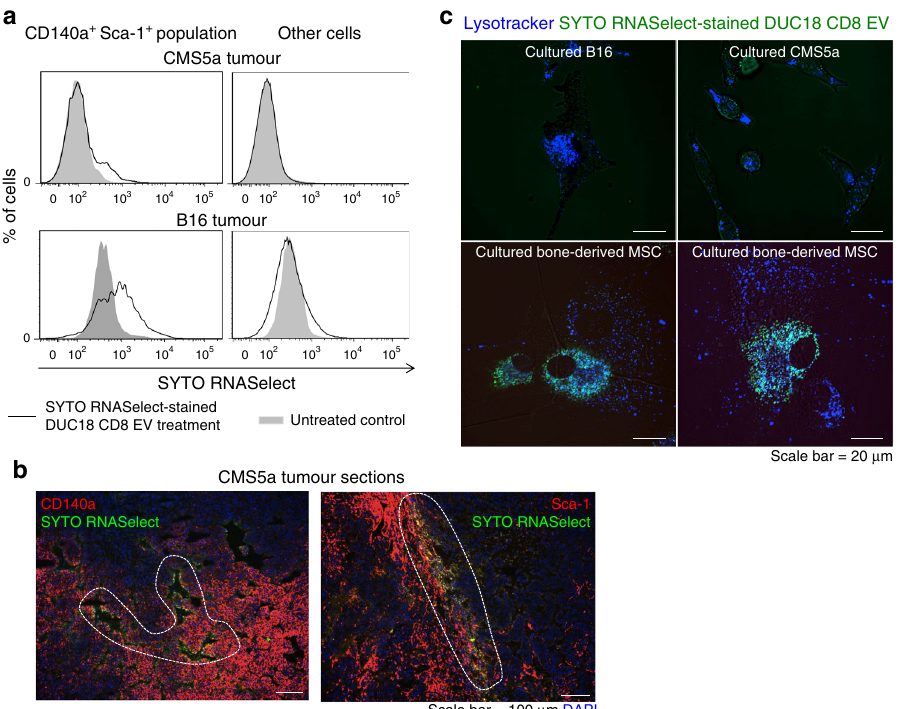
Fig. 3 Rapid engulfment of EV RNAs by mesenchymal cells. a SYTO RNASelect-stained DUC18 CD8 EVs (10 μ g [5 – 7 × 10 8 vesicles]/tumour) were injected into CMS5a and B16 tumours ( n = 3 per group). At 2 h after treatment, the cell suspensions from resected tumours were stained with PE-CD140a- and APC-Sca-1-speci fi c mAbs, and analysed for SYTO RNASelect-derived green fl uorescence in the CD140a + Sca-1 + population or other cells, including tumour cells, by fl ow cytometry. b SYTO RNASelect-stained DUC18 CD8 EVs (10 μ g [5 – 7 × 10 8 vesicles]/tumour) were injected into CMS5a tumours ( n = 3). At 2 h after treatment, the obtained tumours were sectioned and stained with PE-CD140a or PE-Sca-1-speci fi c mAb. Each photo is a representative of 4 – 5 photos. The dotted circles indicate the overlapping areas of PE-originated red and SYTO RNSelect-derived green fl uorescence. c SYTO RNASelect-stained DUC18 CD8 EVs (5 μ g [4 × 10 8 vesicles]/mL) were added to in vitro cultured B16, CMS5a or bone-derived MSCs ( n = 5 per group). Two hours later, the cells were treated with lysotracker (blue), and then observed by confocal laser scanning microscopy. Each photo is a representative of images in 3 – 4